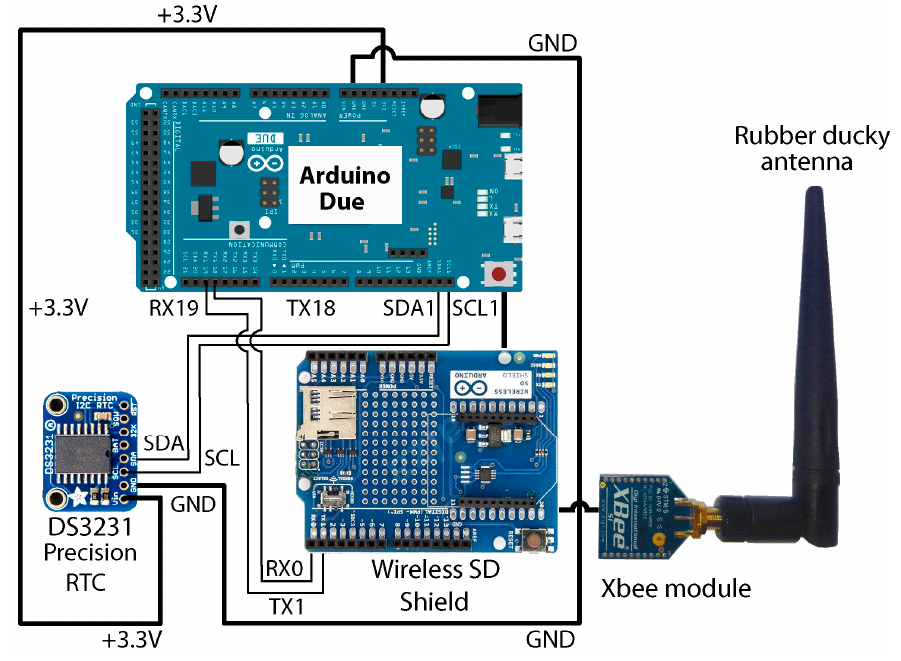
Figure 1. Diagram of the components and connections of the Management Control Node (MCN) system.